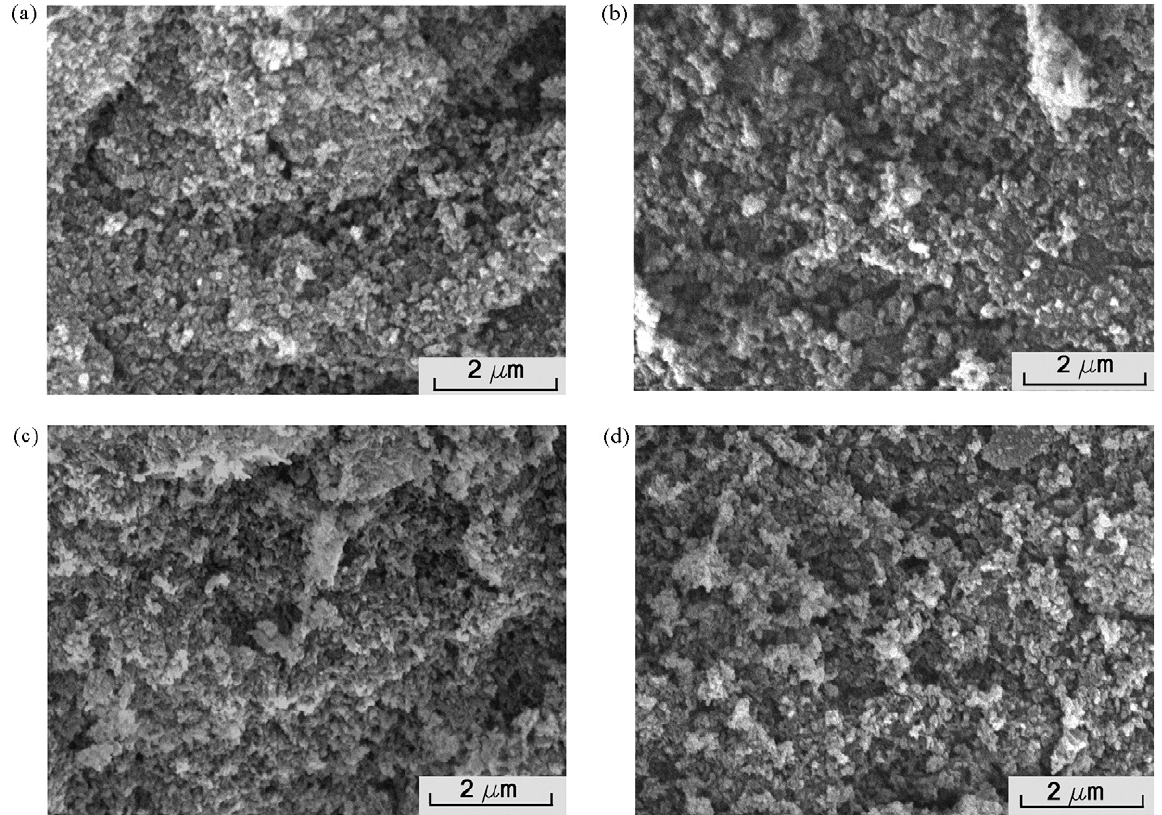
Figure 1. The scanning electron microscope (SEM) micrographs of all the synthesized samples. ( a ) HAP, ( b ) ZnHAP2, ( c ) CuHAP1, ( d ) CuHAP. All the samples consist of similar agglomerates, which